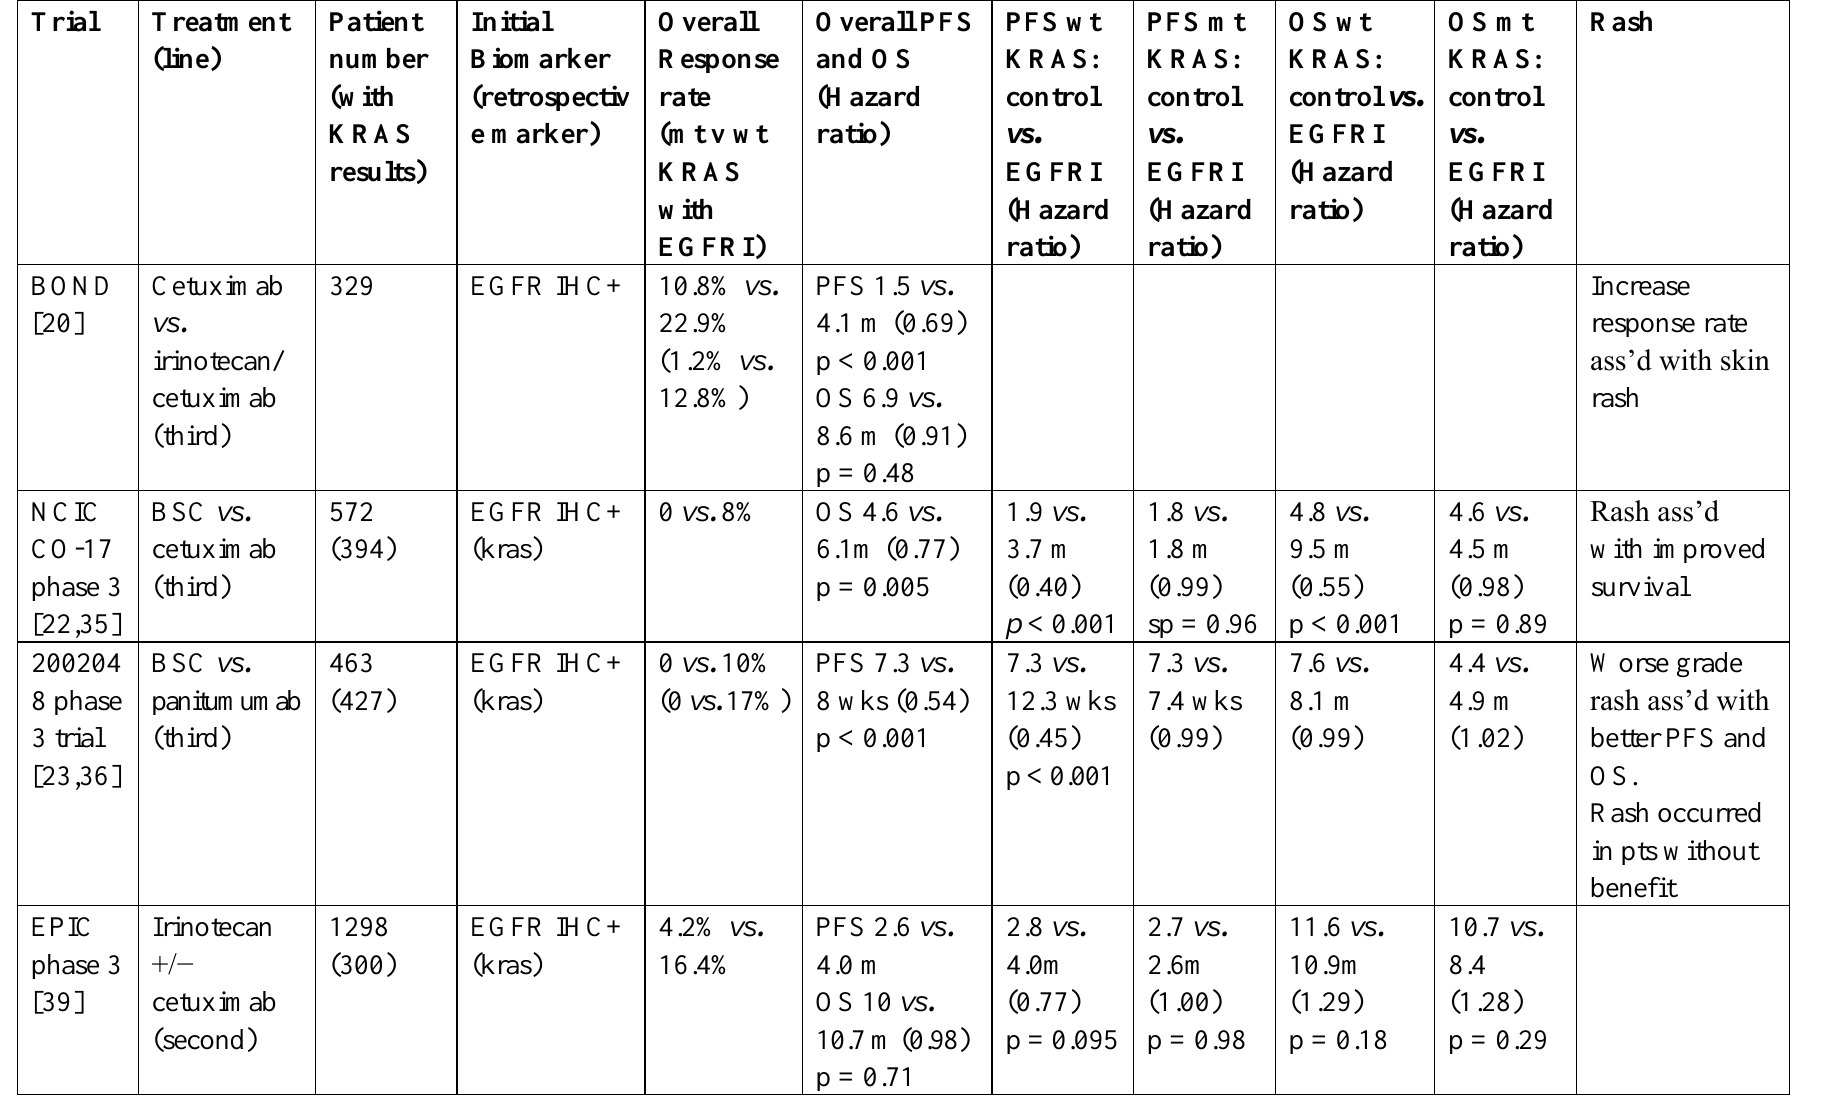
Table 1. Randomized clinical trials of cetuximab and panitumumab in patients with metastatic colorectal